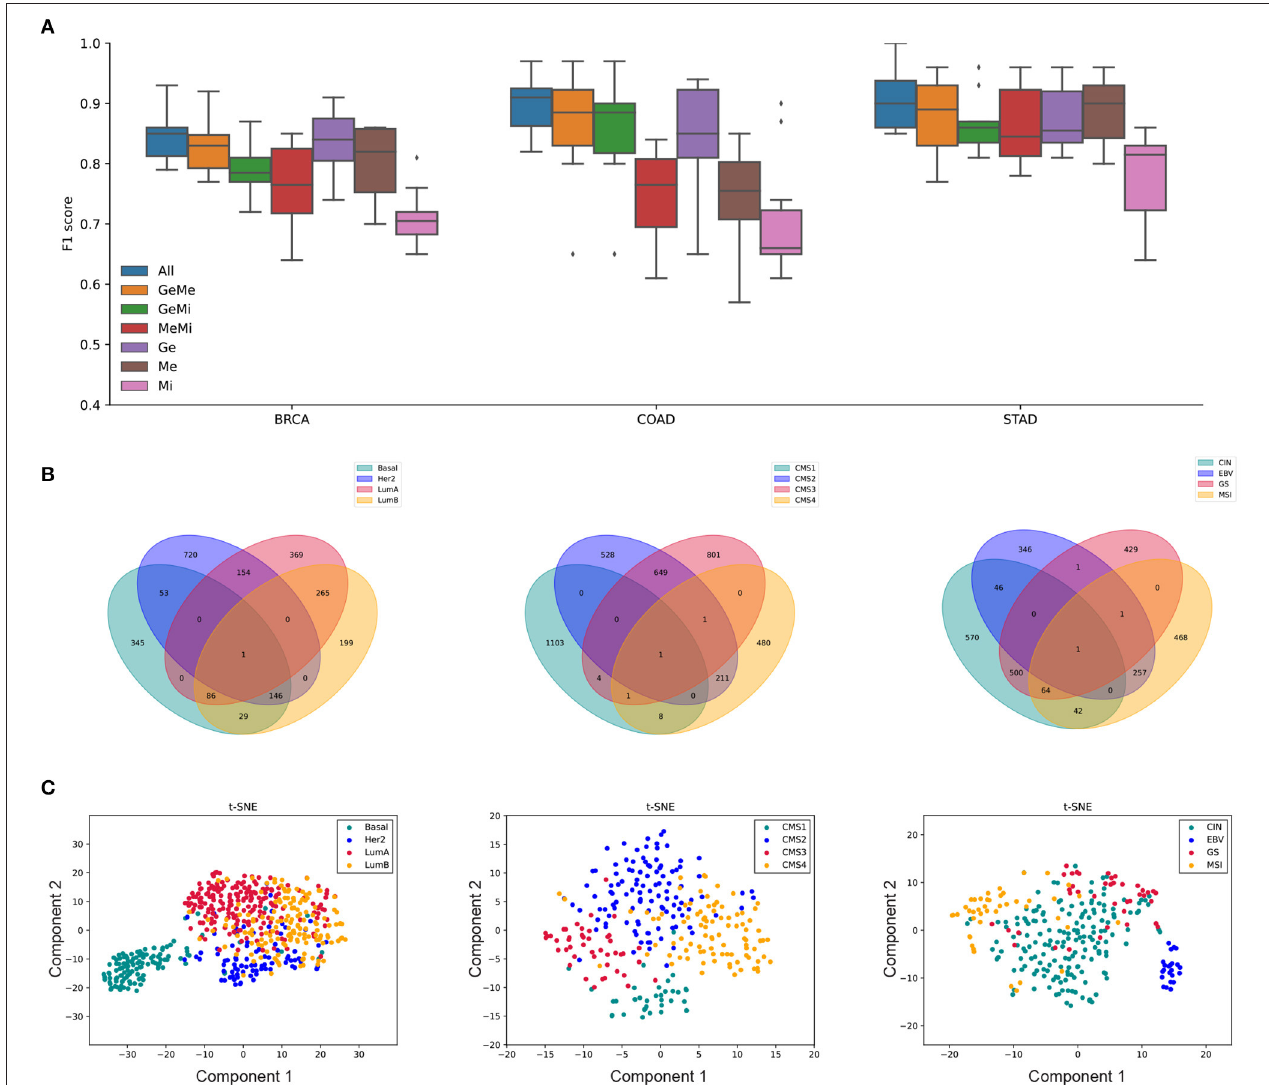
FIGURE 7 | The MONTI analysis results of BRCA, COAD, and STAD subtypes are shown. (A) The subtype classification accuracy was the highest when using all three omics data for all three cancer types. (B) The cancer subtype specific genes. Here, the genes are shared by at most two different subtypes. (C) tSNE plots that were drawn using the selected features from C p of each cancer